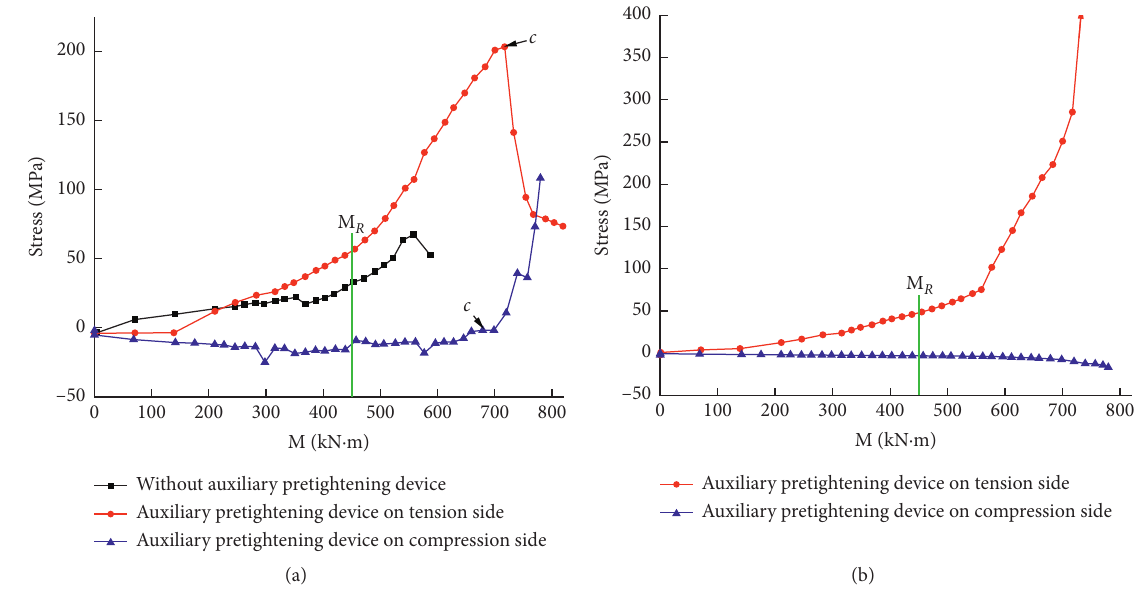
Figure 14: Comparison of rebar stress for different types of double mortise-tenon